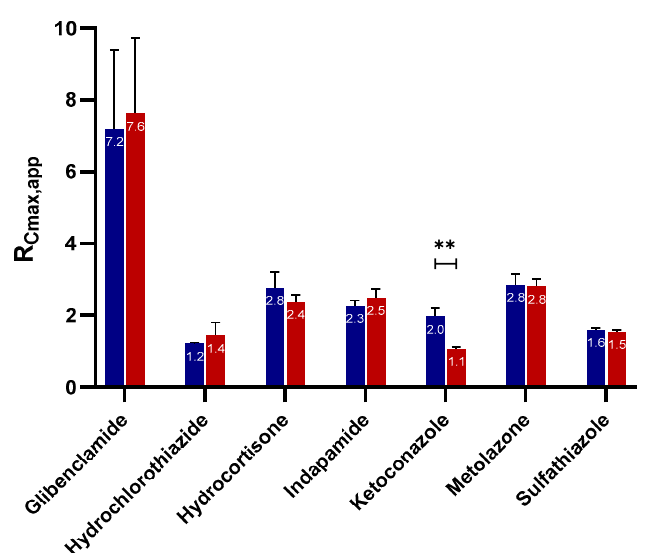
Figure 2. The apparent maximum supersaturation concentration (C max ) ratios (R Cmax,app ) of the fresh and aged and/or crystallized spray-dried APIs at tenfold supersaturation ratios. The freshly spray-dried samples are represented as SD T 0 , whereas the crystallized and/or aged samples are denoted SD T n since each of the APIs crystallized at different time points (see Table 1). At a 95% confidence interval, a p -value of <0.05 is considered statistically significant. The mean ± standard deviation values of three replicates are shown. ** denotes p < 0.01.